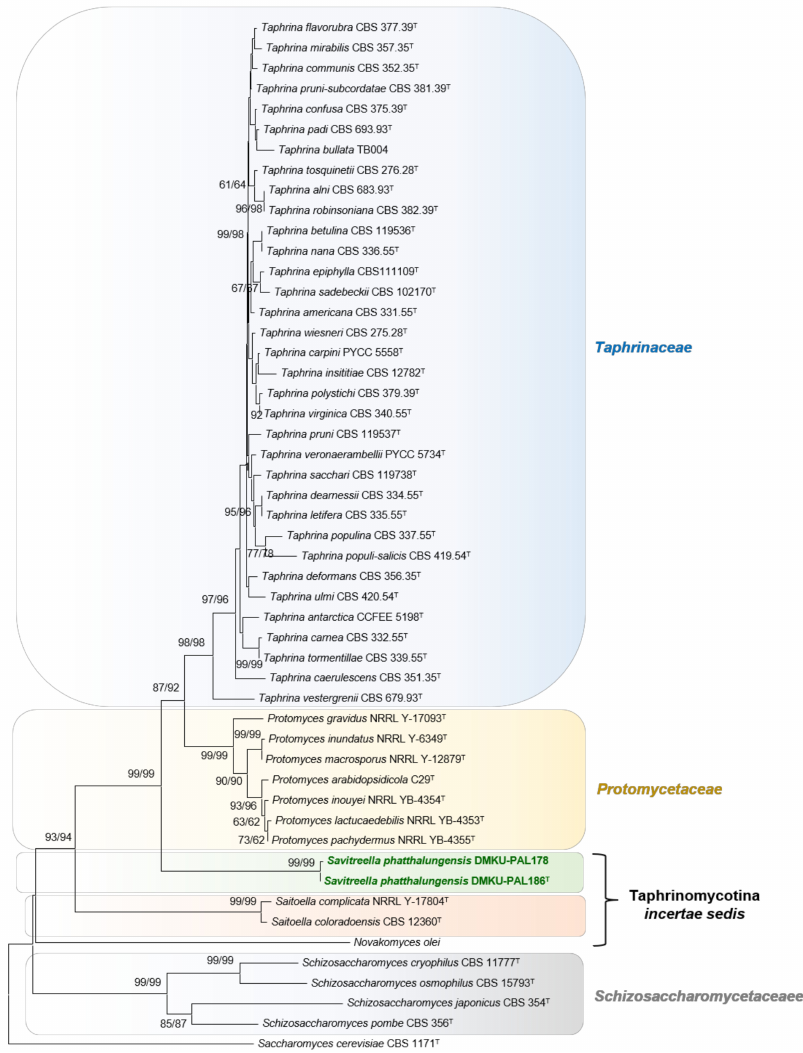
Figure 1. Phylogenetic tree based on the combined sequences of the ITS regions and the D1/D2 domains of the LSU rRNA gene, showing positions of Savitreella phatthalungensis sp. nov. with respect to closely related species. The tree backbone was constructed with the neighbor-joining method by MEGA software. Numbers at the node indicate percentages of bootstrap sampling (BP) of neighbor-joining (NJ) and maximum likelihood (ML) analyses, derived from 1000 samples. All positions containing gaps and missing data were eliminated, resulting in a total of 731 positions in the final dataset. Saccharomyces cerevisiae CBS 1171 T was used as outgroup in these analyses. Bar, patristic distance of